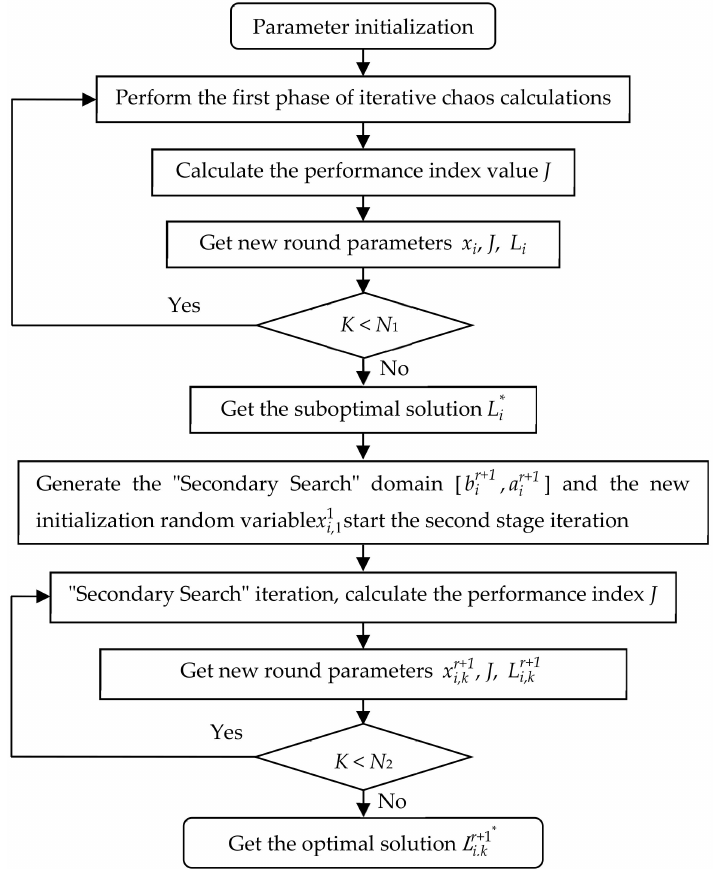
Figure 6. Workflow of chaos optimization.